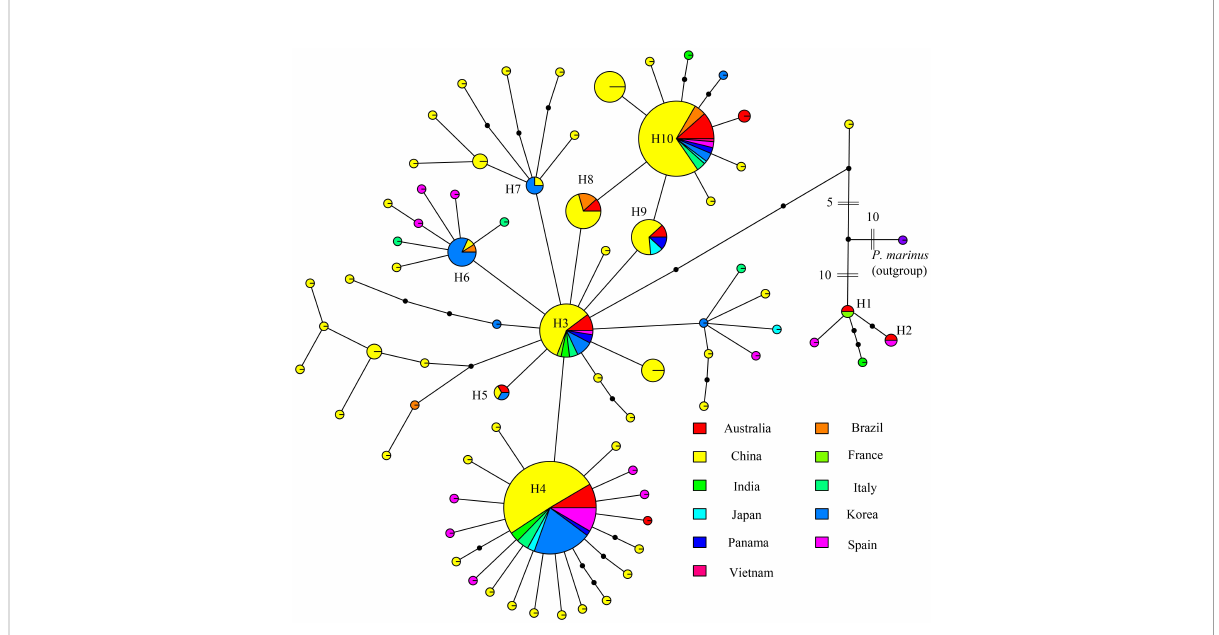
FIGURE 5 Haplotype networks of Perkinsus olseni based on internal transcriber spacer sequences. Colors indicate countries sampled. Neighboring haplotypes without double cross-bars indicate a single nucleotide mutation step or a gap. A nucleotide mutation step or gap of >1 between neighboring haplotypes is marked with double cross-bars, and the total numbers are indicated beside it. Black circles indicate inferred haplotypes not found in the sampled populations. Shared haplotypes are marked from H1 to H10 beside or inside the pie charts. The areas of the circles are proportional to the number of samples of each haplotype. Perkinsus marinus was used as the